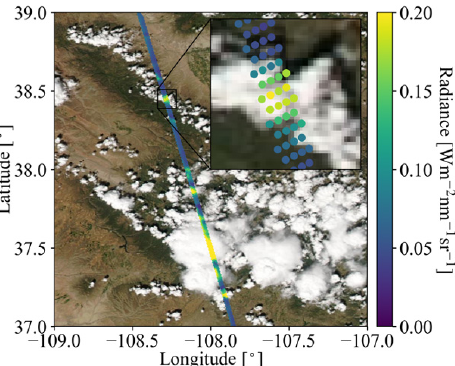
Figure 2. OCO-2-measured radiance (Wm − 2 nm − 1 sr − 1 ) at 768.52nm, overlaid on MODIS Aqua RGB imagery over south- western Colorado (USA) on 2 September 2019. The inset shows an enlarged portion along the track, illustrating that OCO-2 radi- ances co-vary with MODIS-Aqua radiance observations (the circles are used to indicate the geolocation of OCO-2